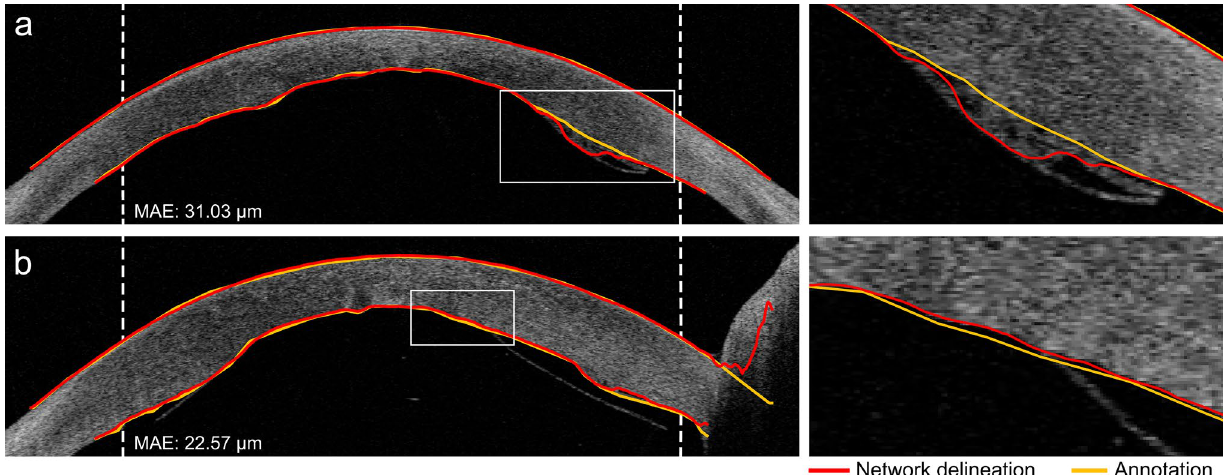
Figure 3. Two examples of B-scans including the annotations and delineations by the CNN with dimension reduction with substantial deviations in predicted thickness. The rectangular areas are enlarged and displayed to the right of the B-scan. Vertical dashed lines indicate the 9 mm diameter. Note that the thickness was not evaluated outside of the 9 mm diameter. Immediately after DMEK